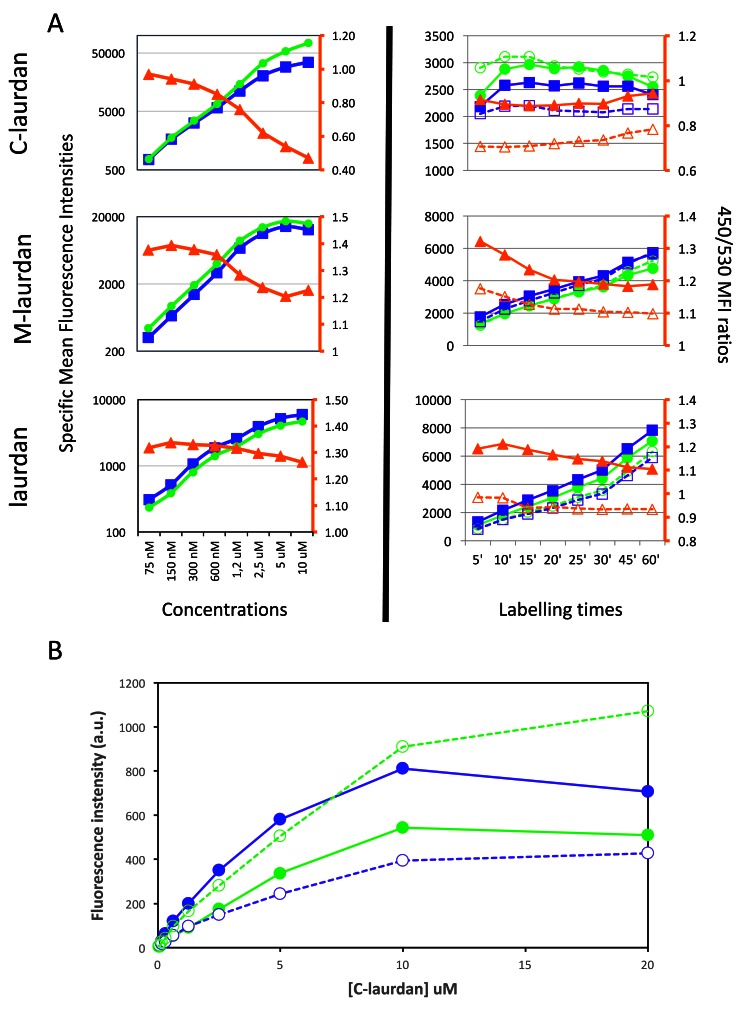
Using flow cytometry (FACS) to quantify staining intensities at 450 and 530 nm, as well as the ratio between the two.(
A) FACS was used to quantify the mean fluorescence intensities (MFIs) of Hela cells labelled with C-laurdan (top), M-laurdan (middle) or laurdan (bottom). Blue squares indicate MFI at 450 nm and green circles indicate MFI at 530 nm, as plotted on the y-axis on the left side of each plot. Orange triangles indicate the ratio of 450/530 MFIs as plotted on the orange y-axis on the right side of each plot. The plots in the left column show dose–response curves after labelling cells at 37°C for 60 minutes. The plots in the right column show time courses of cells labelled at 37°C with either 200 nM C-laurdan, 500 nM M-laurdan or 4 µM laurdan. The unfilled blue squares and orange triangles indicate measurements as for the filled symbols, but on cells treated with 5 mM MßCD for 30 min at 37°C before labelling. (
B) The preferential autoquenching of C-laurdan in Lo environments, suggested by the drop in the 450/530 ratio in the FACS analysis of cells labelled with high concentrations of the probe, can also be seen in MLVs analysed on a standard spectrofluorimeter. Serial two-fold dilutions of C-laurdan in DMSO were added (1% vol), whilst vortexing, to aliquots of MLVs prepared either with DOPC (Ld, dotted lines) or with DPPC–chol (Lo, continuous lines). After 20 min incubation at 37°C, the emission spectra of each aliquot were recorded in quartz cuvettes in a standard spectrofluorimeter (excitation: 360 nm), and the fluorescence intensities at 440 nm (blue lines) and 490 nm (green lines) were plotted against the concentration of C-laurdan.